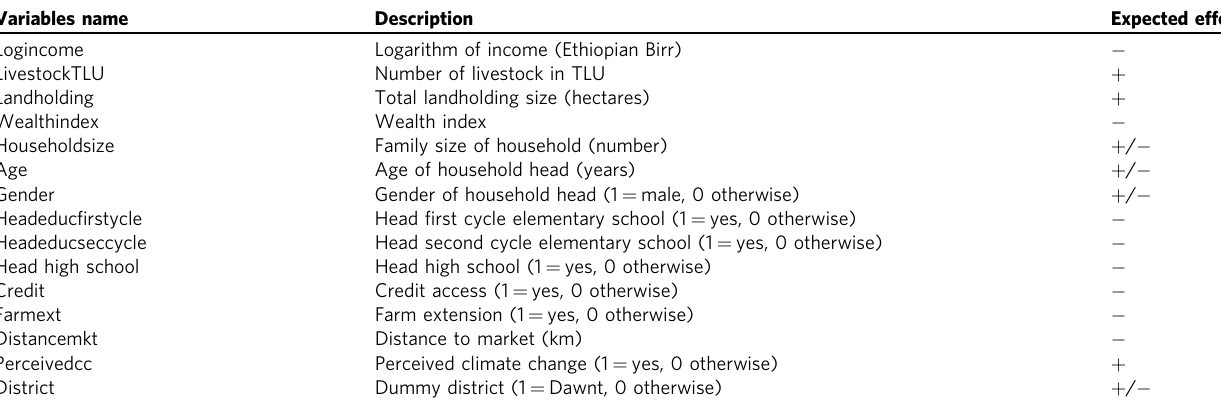
Table 2 Description of determinants and their expected effects on intensity of land allocation to grass pea